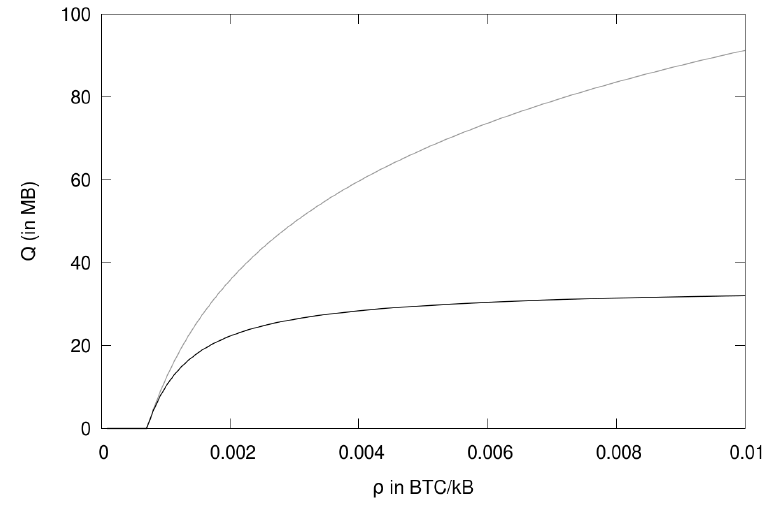
Fig. 1. Q as a function of ρ as obtained in Equations 4 (light grey) and 5